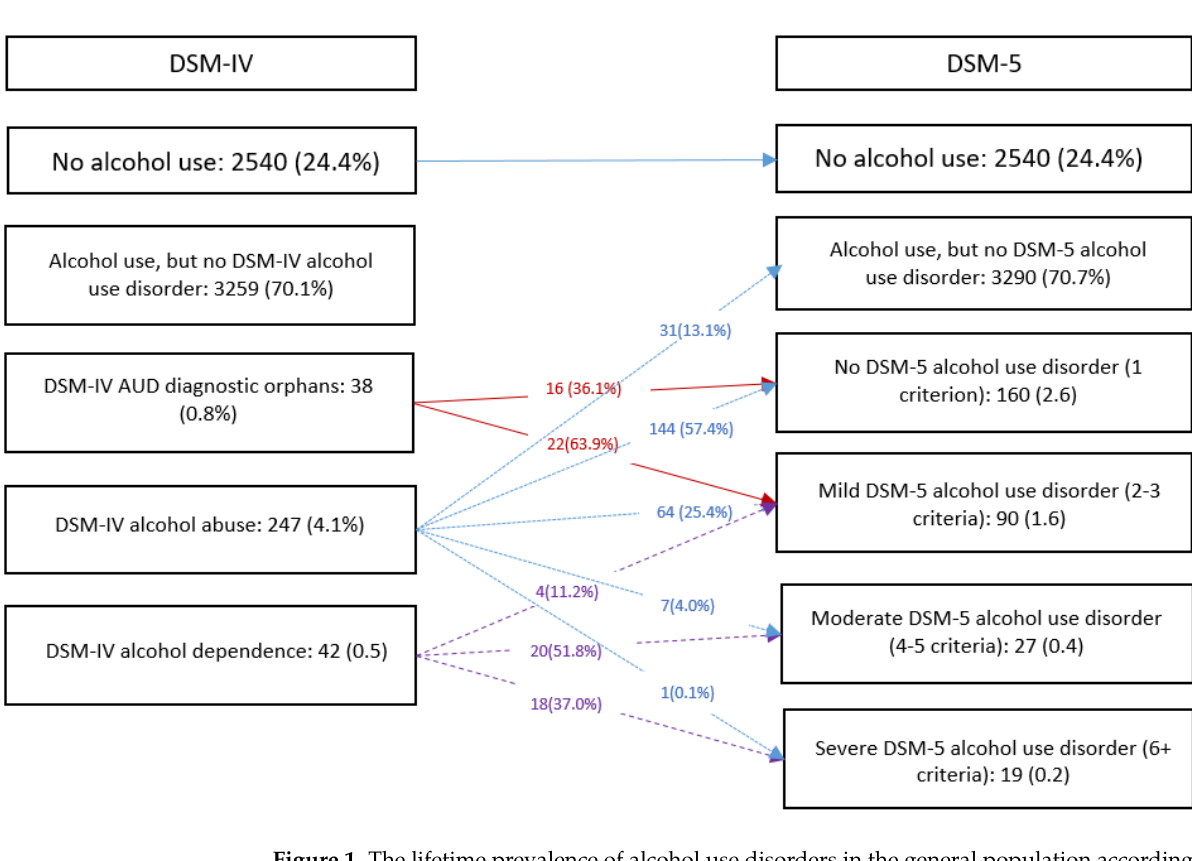
Figure 1. The lifetime prevalence of alcohol use disorders in the general population according to the DSM-IV and DSM-5 criteria ( n = 6126).